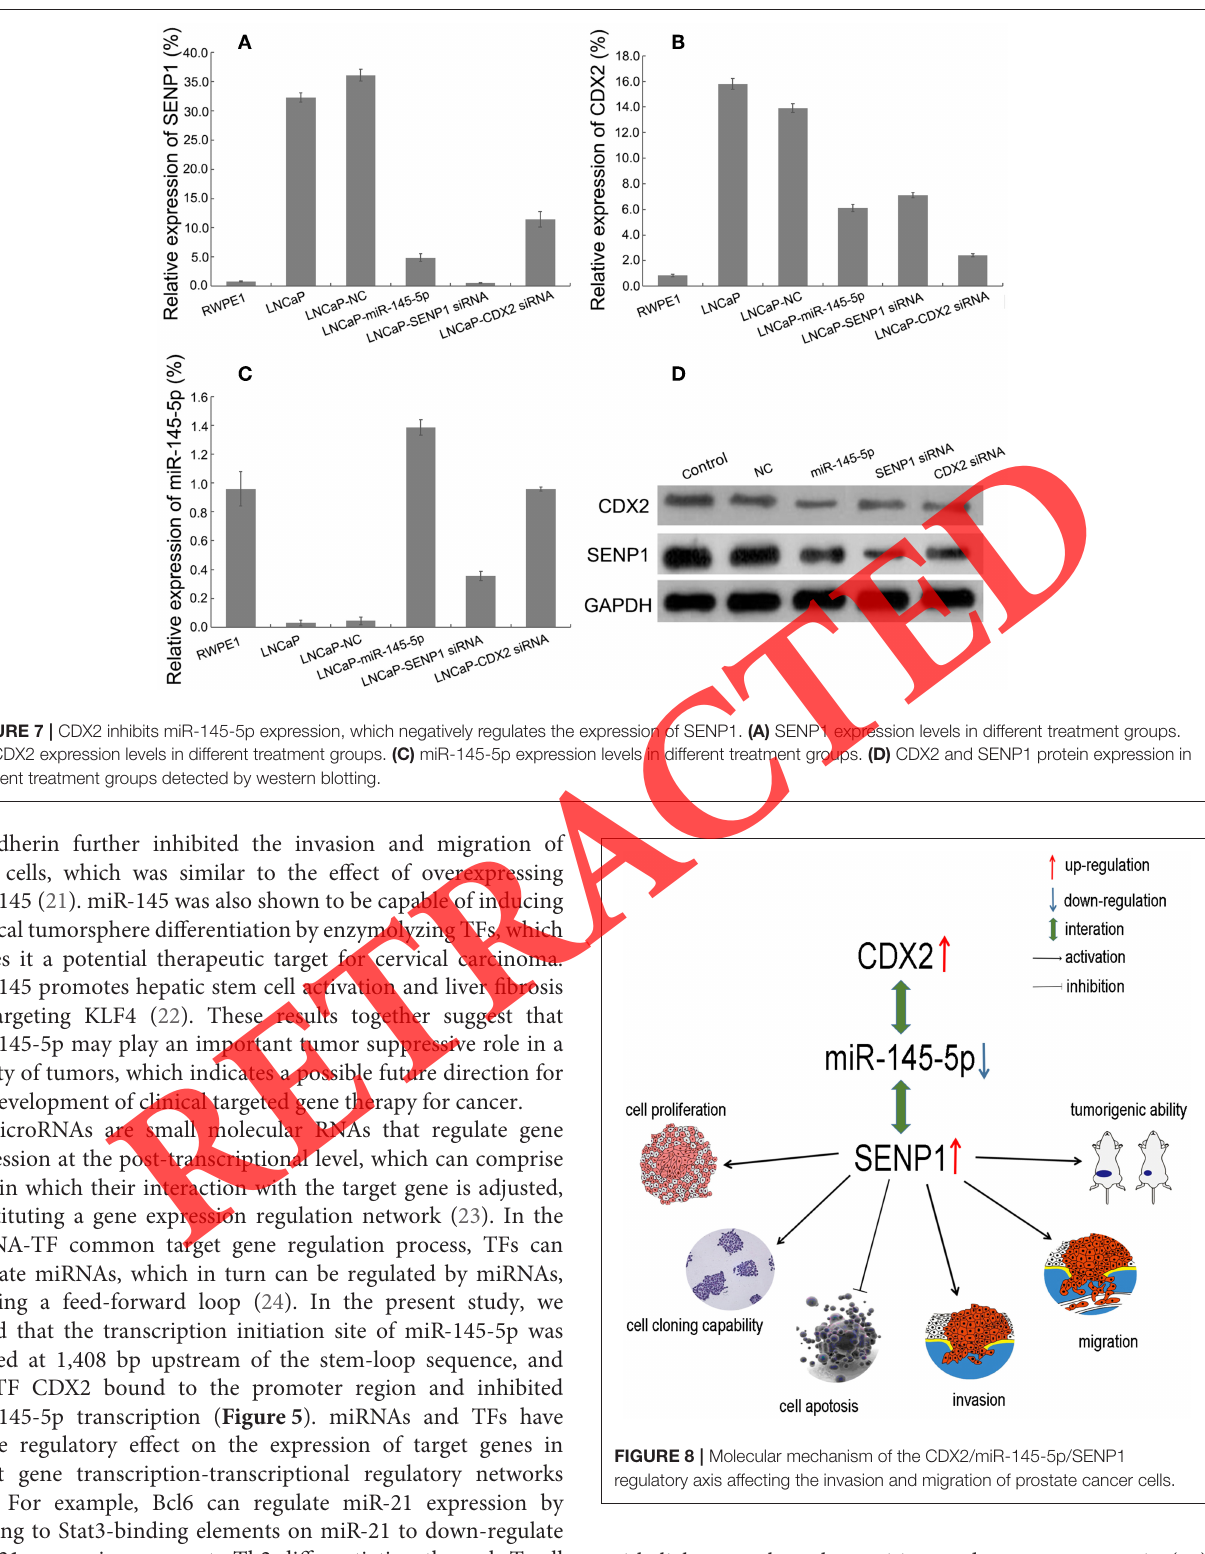
epithelial-mesenchymal transition and tumor metastasis